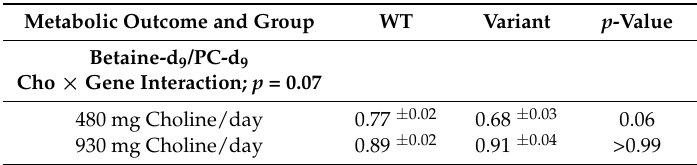
Table 5. Comparison of betaine-d 9 /PC-d 9 enrichment ratios between CHDH rs9001 genotypes by choline intake group. Values are least-squared means ± standard errors in ratios.